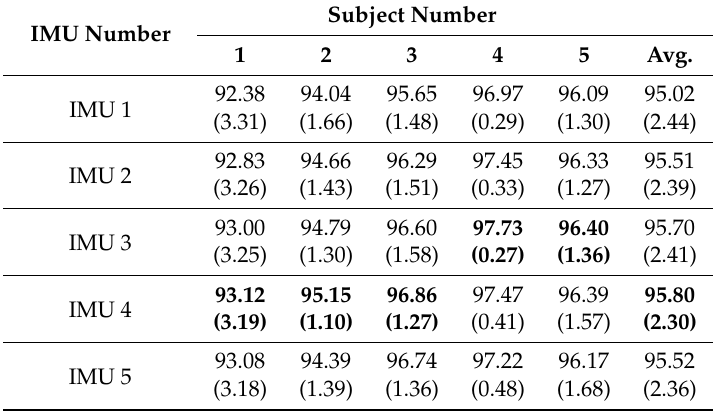
Table 3. Comparison of the mean (standard deviation) test accuracies of the di ff erent inertial sensors. IMU Number